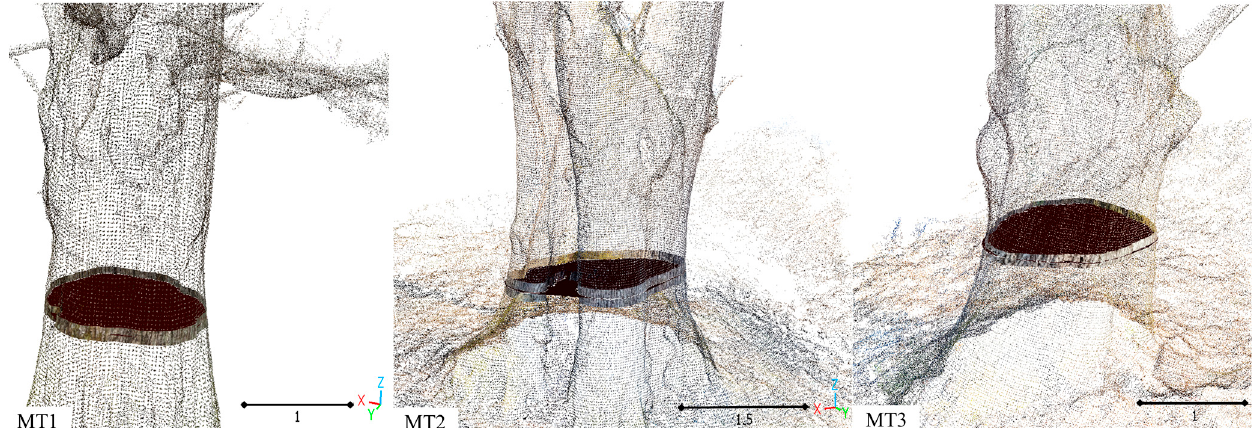
Figure 6. Mesh of the DBH sections from the SLR dense clouds in the three monumental trees (MT1, MT2 and MT3).